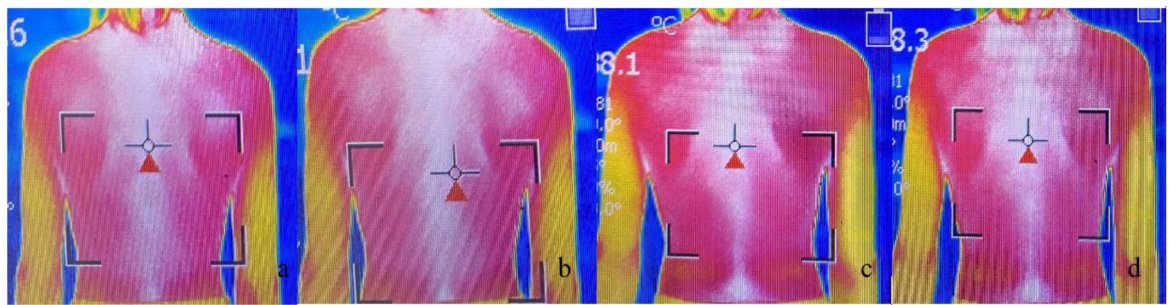
Figure 4. Subject 3 without scoliosis ( a ) image taken at the beginning; ( b ) image taken at the end of exercise 1; ( c ) image taken at the end of exercise 2; ( d ) image taken at the end of exercise